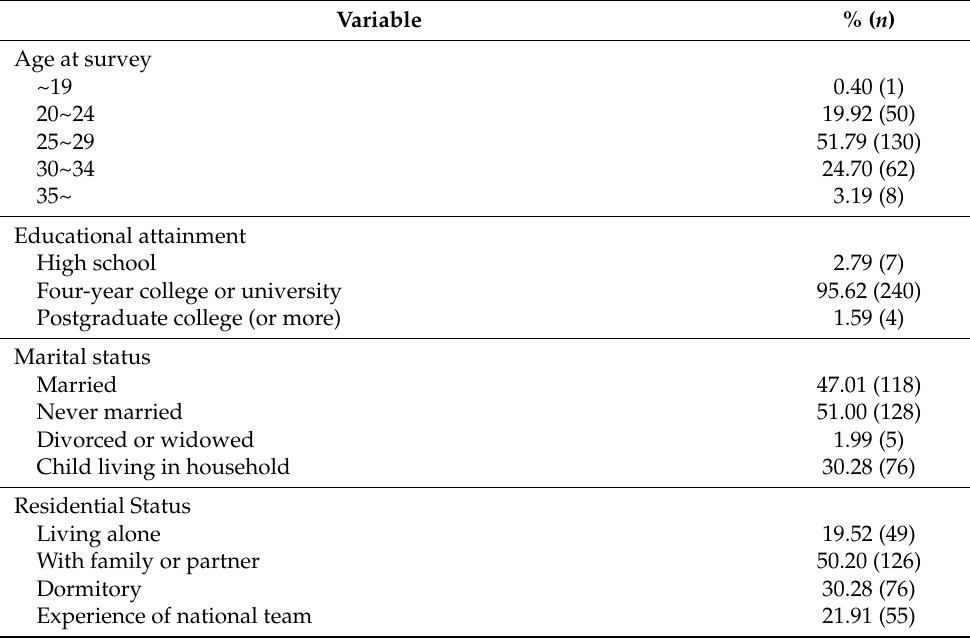
Table 1. Demographic characteristics of the study participants and their experience of life events.